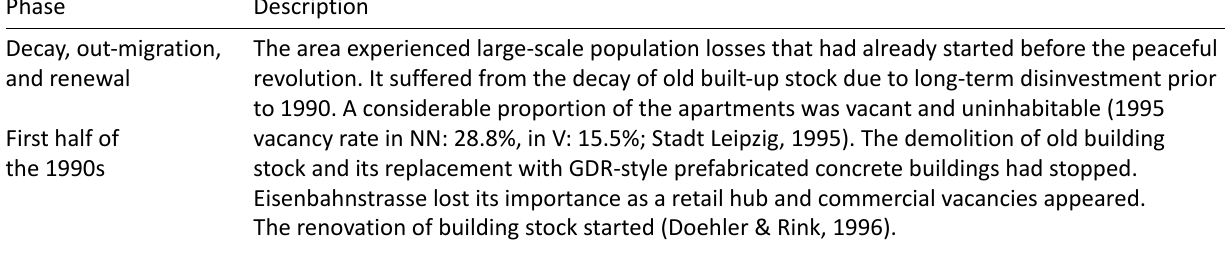
Table 1. Development of Leipzig’s inner east since 1990.